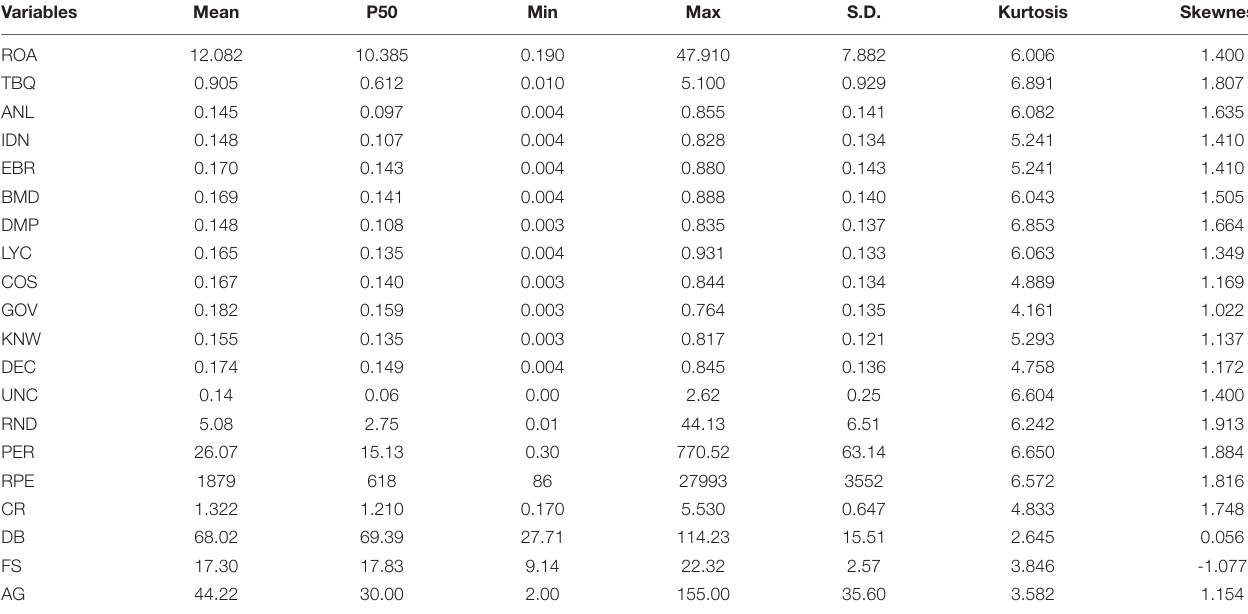
TABLE 3 | Descriptive statistics and measures of skewness, kurtosis test for variables.